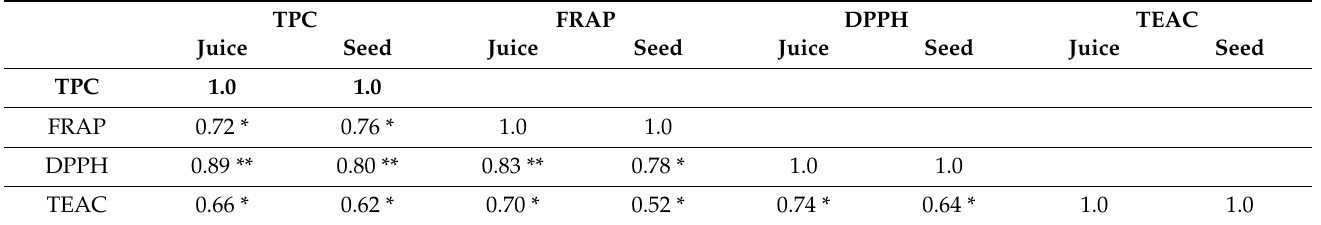
Table 3. Correlation between the TPC and antioxidant capacities by FRAP, DPPH and